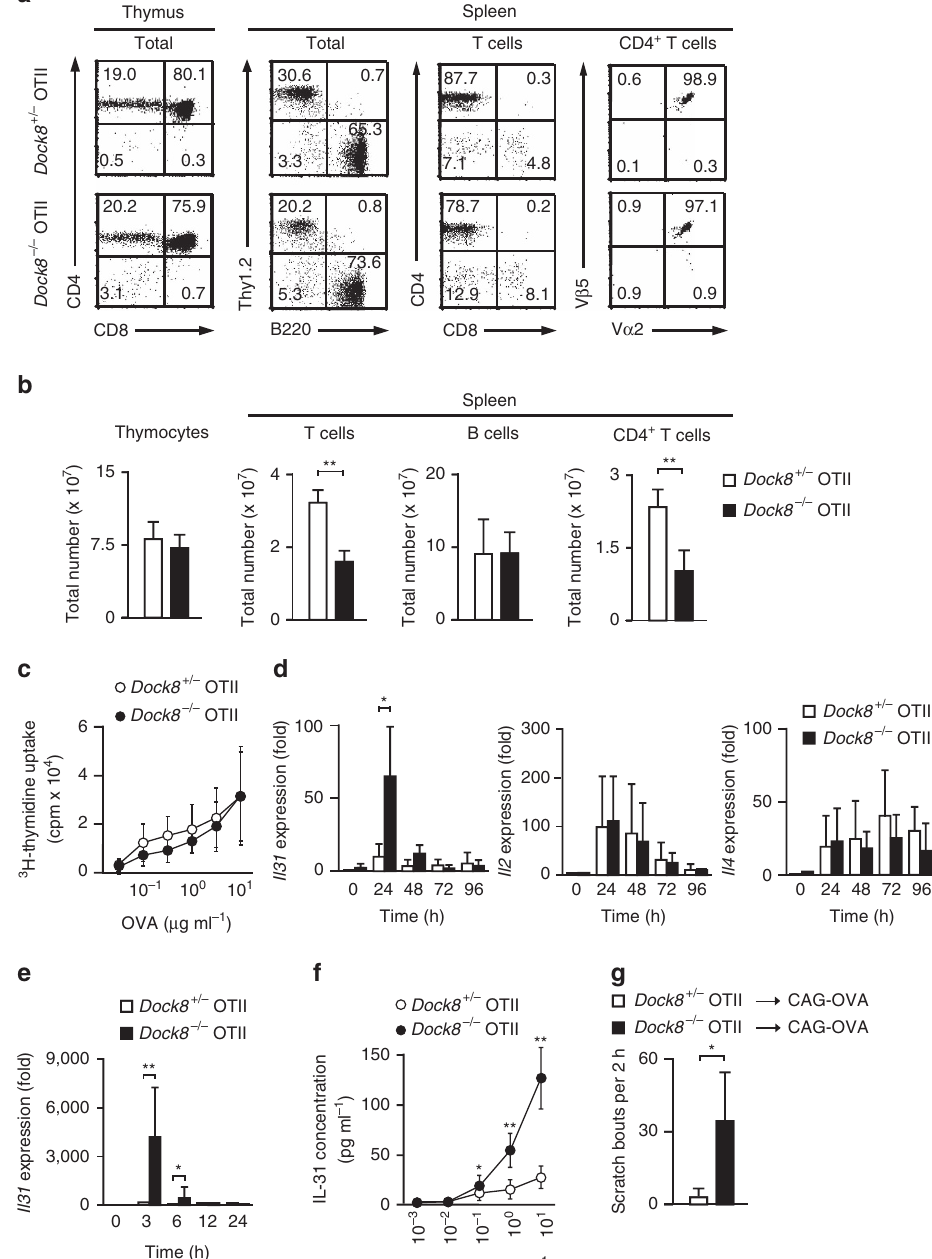
Figure 1 | DOCK8 negatively regulates IL-31 induction in CD4 þ Tcells. ( a , b ) Flow cytometric analyses of thymocytes and spleen cells from 6- to 8-week- old Dock8 þ / (cid:2) and Dock8 (cid:2) / (cid:2) OTII Tg mice. The numerals in quadrants indicate the percentage of each subset of leukocytes. Data are expressed as mean ± s.d. of 5 mice per group. ** P o 0.01 (two-tailed Student’s t -test). See Supplementary Fig. 10 for FACS gating strategy. ( c ) Antigen-specific proliferation of CD4 þ Tcells from Dock8 þ / (cid:2) and Dock8 (cid:2) / (cid:2) OTII Tg mice. Data are expressed as mean ± s.d. of 12 samples per group. ( d ) Induction of cytokine gene expression in CD4 þ T cells from Dock8 þ / (cid:2) and Dock8 (cid:2) / (cid:2) OTII Tg mice after primary stimulation with OVA peptide. Expression (fold increase) is relative to that of unstimulated Dock8 þ / (cid:2) samples. Data are expressed as mean ± s.d. of 8 samples per group. * P o 0.05 (two-tailed Student’s t -test). ( e ) Il31 gene expression in CD4 þ Tcells from Dock8 þ / (cid:2) and Dock8 (cid:2) / (cid:2) OTII Tg mice after secondary stimulation with anti-CD3 e and anti-CD28 antibodies. Expression (fold increase) is relative to that of Dock8 þ / (cid:2) samples without secondary stimulation. Data are expressed as mean ± s.d. of 10 samples per group. * P o 0.05; ** P o 0.01 (two-tailed Student’s t -test). ( f ) ELISA showing increased IL-31 production by Dock8 (cid:2) / (cid:2) OTII Tg CD4 þ Tcells after secondary stimulation. Data are mean ± s.d. of 9 samples per group. * P o 0.05; ** P o 0.01 (two-tailed Student’s t -test). ( g ) Induction of itch in CAG-OVA mice by adoptive transfer of activated CD4 þ Tcells from Dock8 (cid:2) / (cid:2) , but not Dock8 þ / (cid:2) , OTII Tg mice. Data are expressed as mean ± s.d. of four mice per group. * P o 0.05 (two-tailed Mann–Whitney